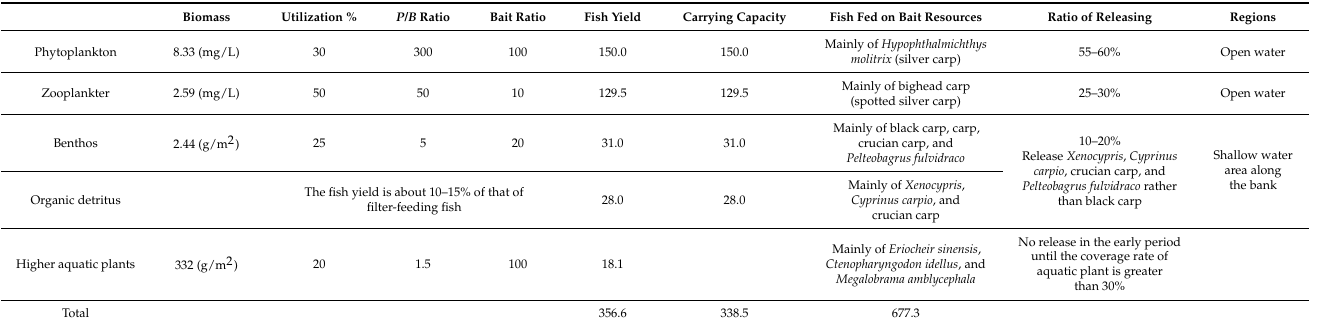
Table 4. Estimation of current annual fish productivity of various feed resources in Shengjin Lake (ten thousand